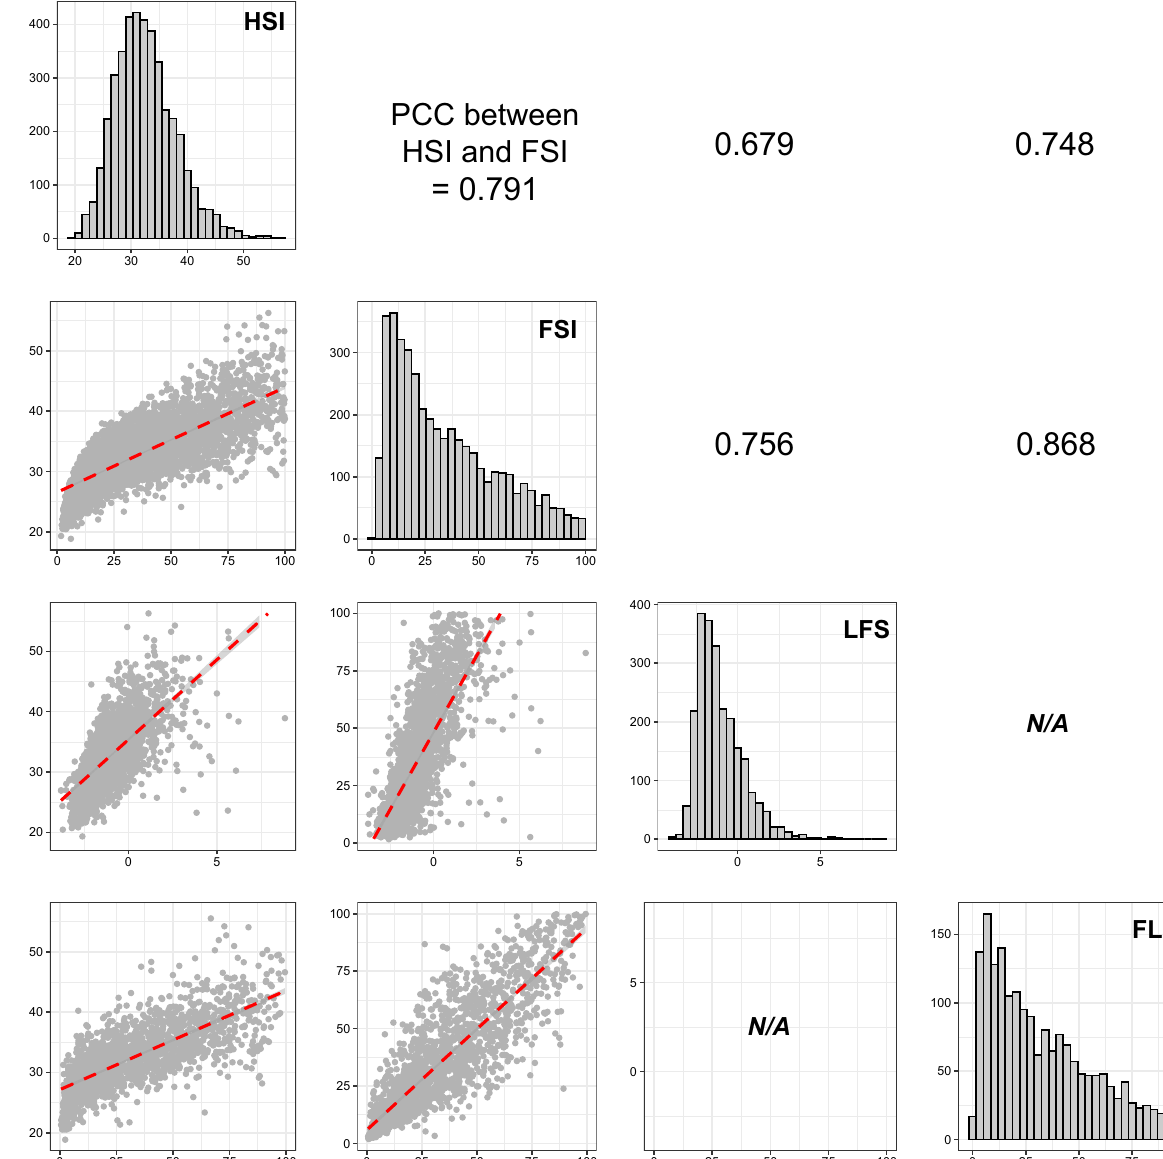
Figure 2. Correlation matrix among four indices for fatty liver in Korean men ( A ) and women ( B ). Distributions located in the diagonal are for each index for fatty liver. A scatter plot in the xth row and yth column indicates the correlation between xth index and yth index, and its slope is described by a red dotted line in the scatter plot and a value placed on the xth column and yth row. Comparison between LFS and FLI could not be performed because no sample had both data. Figures in the upper triangle matrix indicate PCC. HSI hepatic steatosis index, FSI Framingham steatosis index, LFS NAFLD liver fat score, FLI fatty liver index, PCC Pearson’s correlation